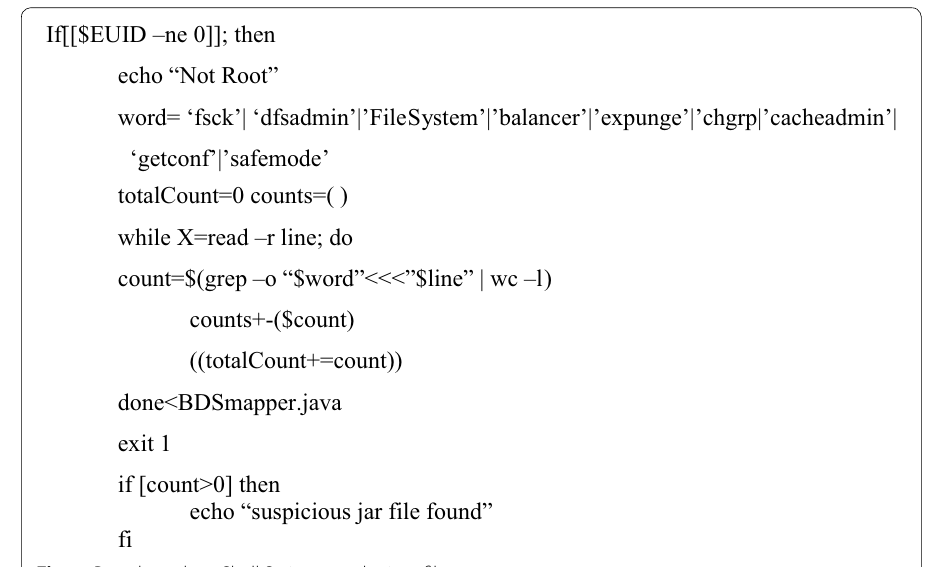
Fig. 7 Pseudo code —Shell Script to probe java